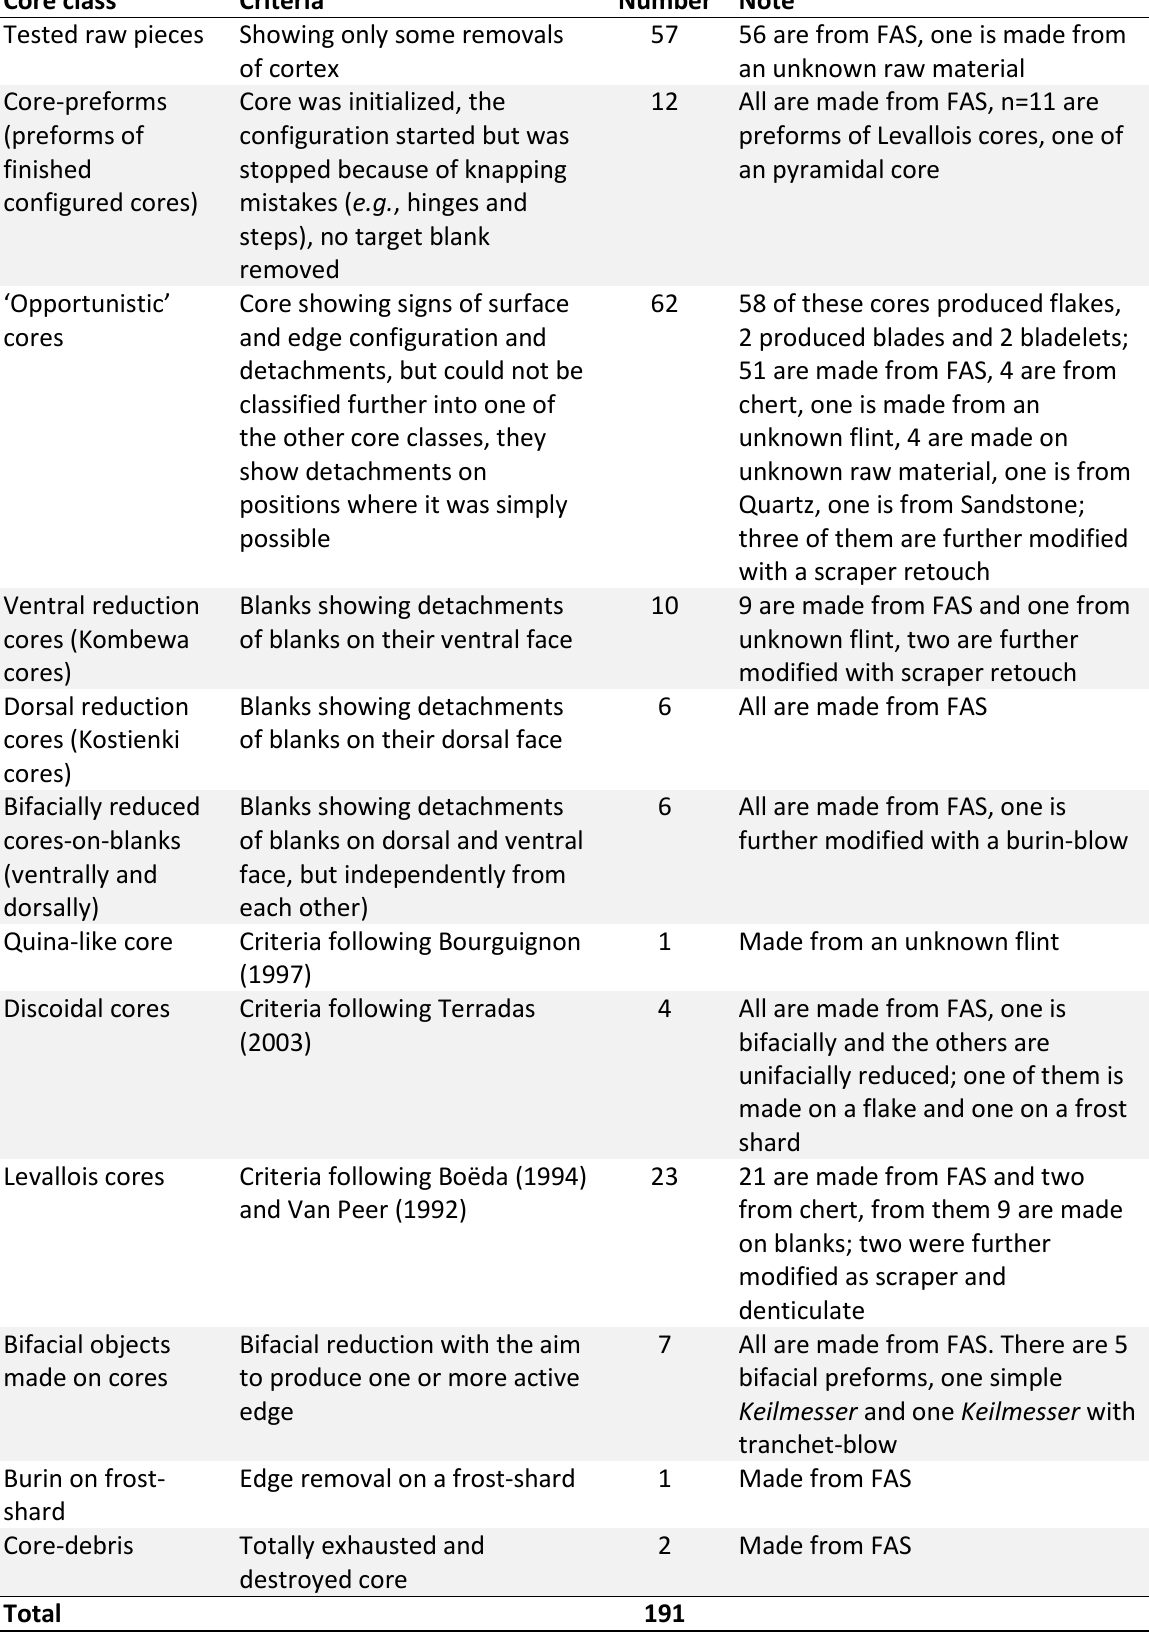
Table 7. Cores from GH 3 (excluding hammerstones and anvils with negatives of